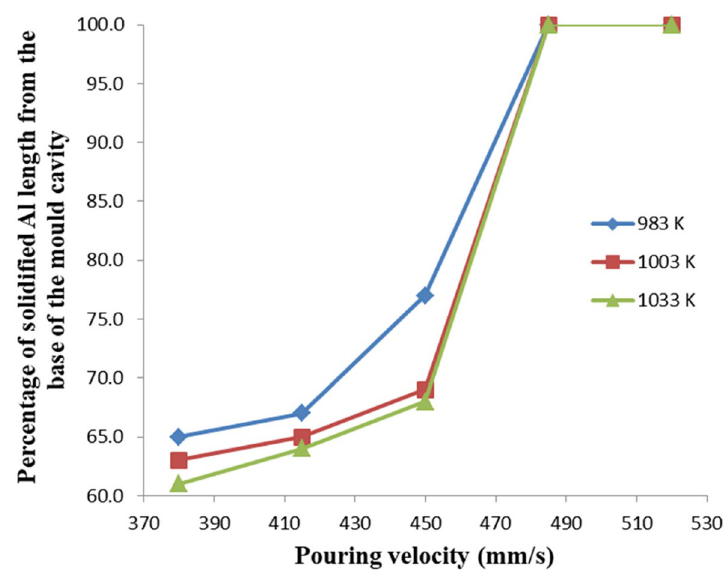
Fig. 12 Variation of solidified Al length from the base of mould